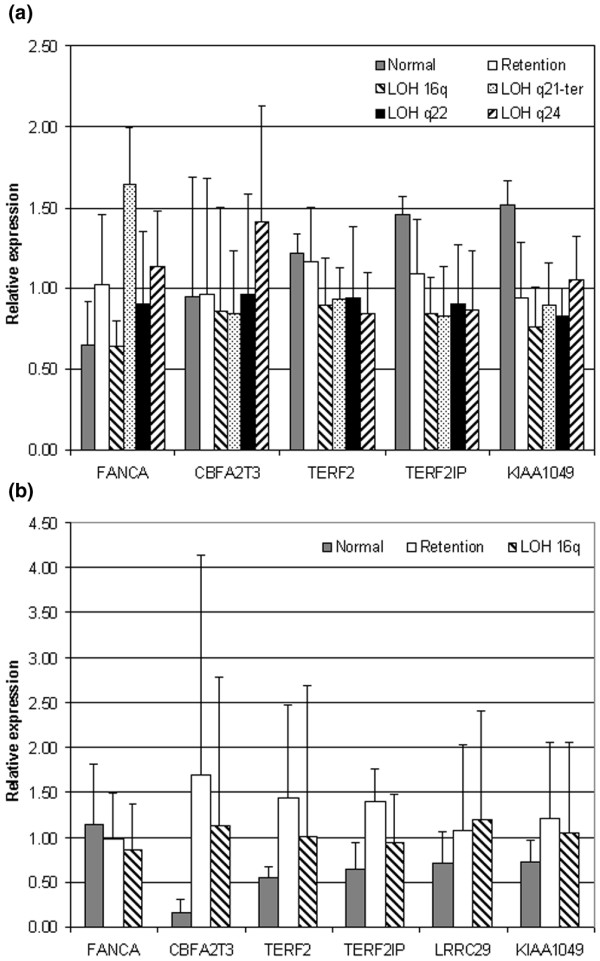
Quantitative reverse transcriptase PCR expression analysis in breast cancer cell lines and tumours. Expression analysis in (a) breast cancer cell lines and (b) breast tumours stratified according to their loss of heterozygosity (LOH) status on the long arm of chromosome 16.